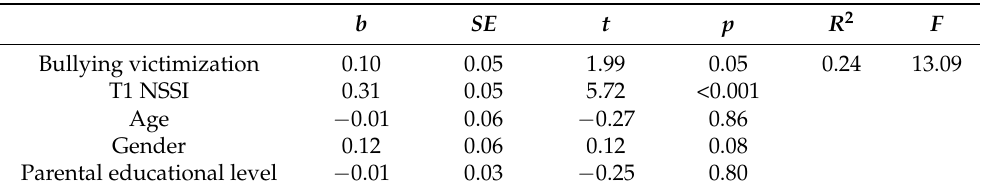
Table 2. Regression analysis of the longitudinal association between T1 bullying victimization and T2 NSSI.